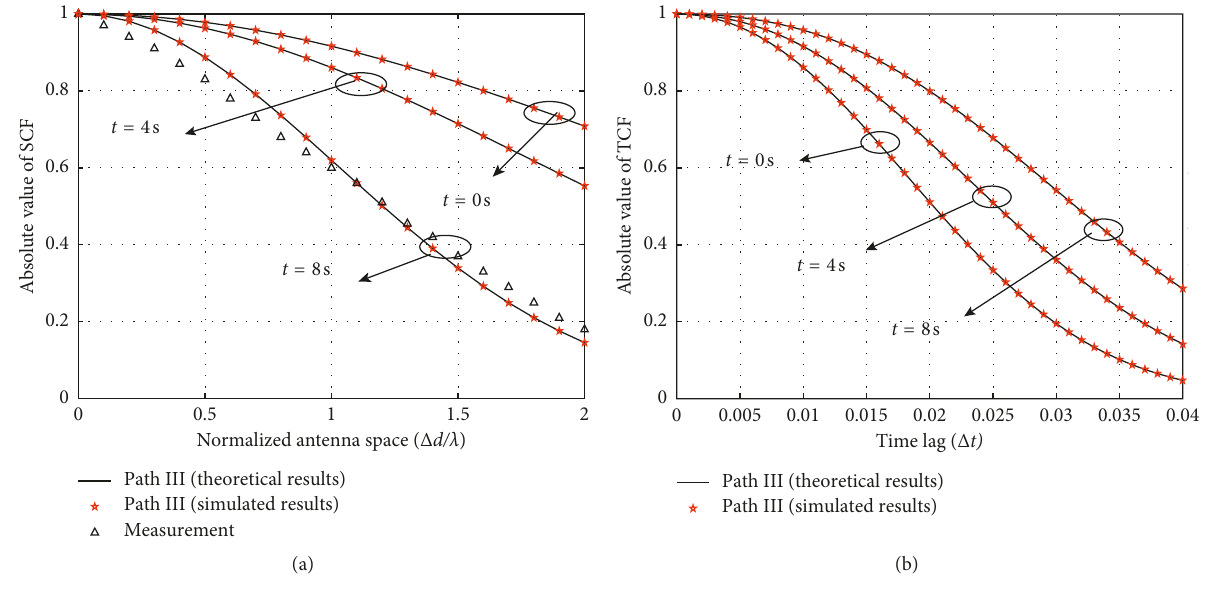
Figure 6: Comparison of absolute theoretical and simulated (a) SCFs and (b) TCFs at different time instants.